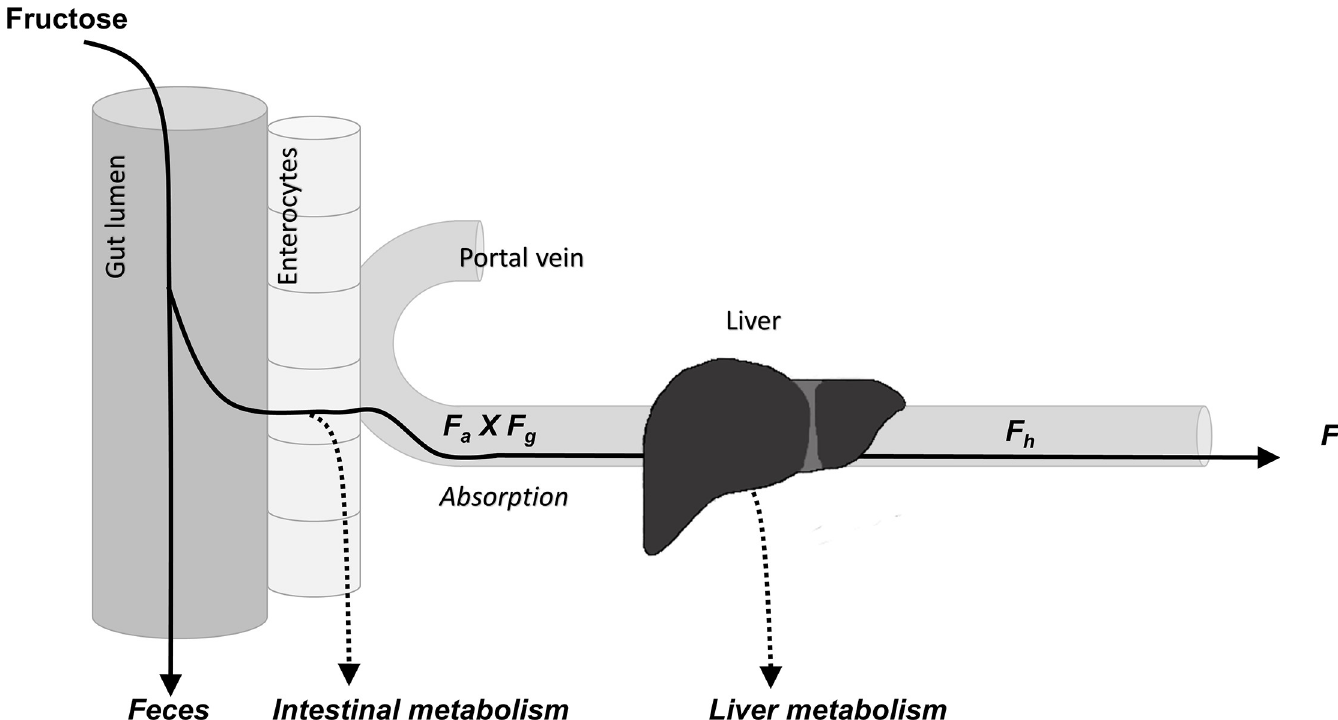
Fig 1. Fructose intestinal, hepatic, and oral bioavailability. F a x F g = intestinal availability or fructose absorption. F h = hepatic availability. F = oral bioavailability.